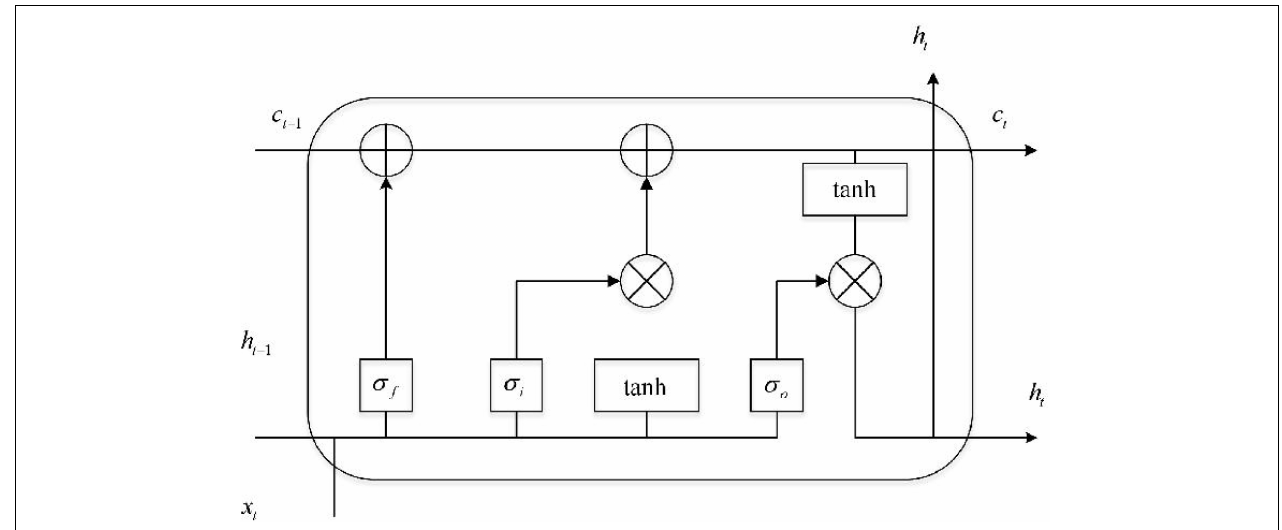
FIGURE 1 | LSTM neural network